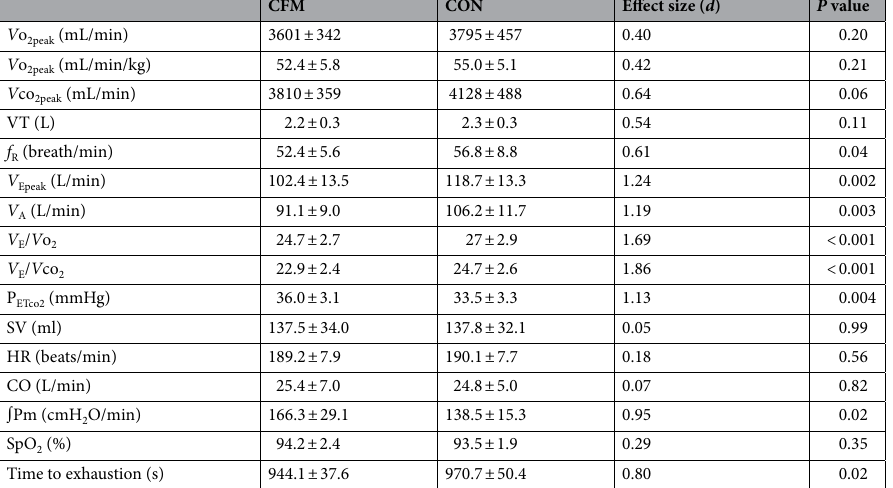
Table 2. Variables for cardiorespiratory responses for V O 2peak intensity. CFM, cloth face masked trial; CON, unmasked control trial; V o 2peak , peak oxygen uptake; V co 2peak , peak carbon dioxide elimination; VT, tidal volume; f R , respiratory frequency; V Epeak , peak minute ventilation; V A , alveolar ventilation: P ETco2 , end-tidal partial pressure of CO 2 ; SV, stroke volume; HR, heart rate; CO, cardiac output; ∫Pm, the integral absolute value of mouth pressure; SpO 2 , arterial oxy-hemoglobin saturation. Values are expressed as the mean ± SD.